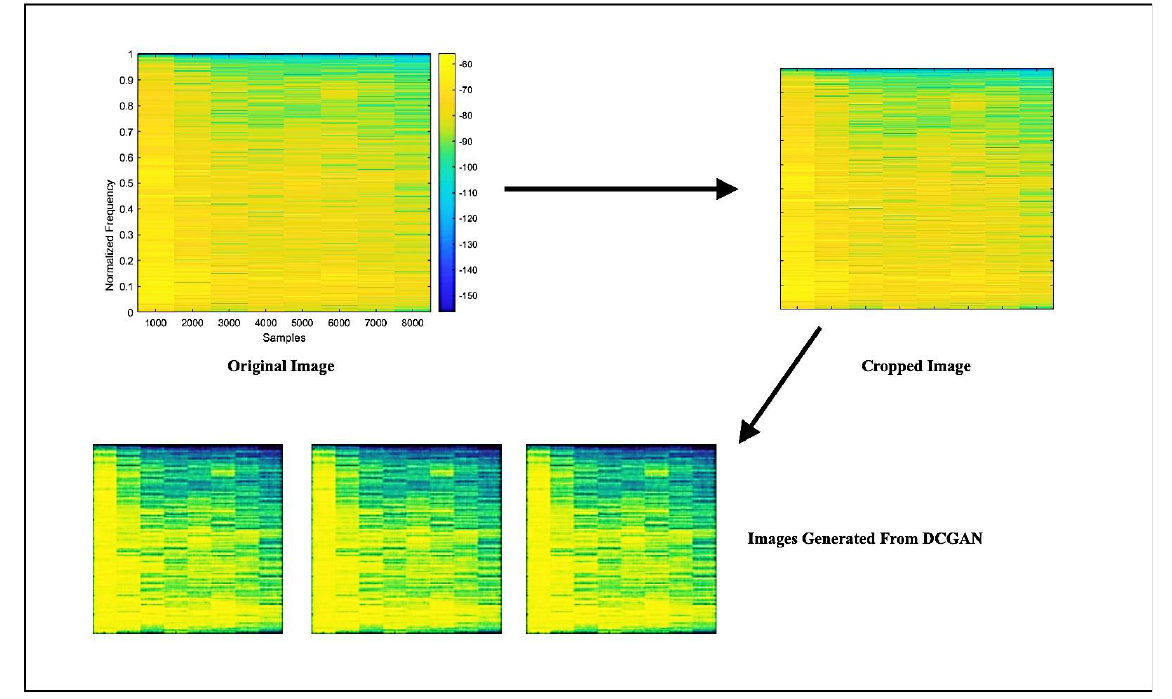
Figure 5. Synthetic scalograms generated from DCGAN. Table 3. Sample feature vector without standardization.